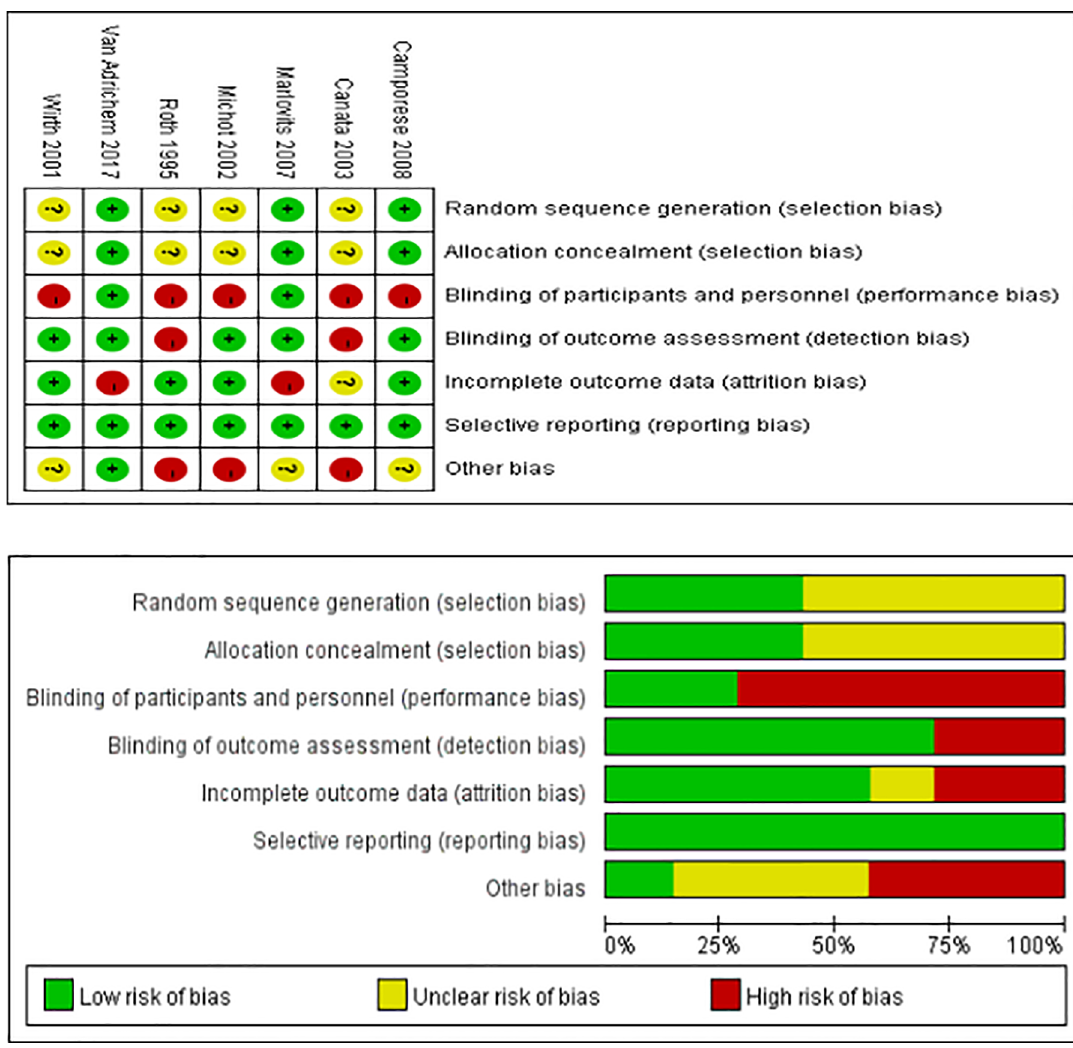
Fig 2. Risk of bias of the selected studies according to the Cochrane Collaboration tool. Panel A: Risk of bias graph: judgement regarding each risk of bias item presented as percentages across all studies. Panel B: Risk of bias summary: judgement regarding each risk of bias item for each study. A (+), indicates a low risk of bias; a (-), indicates a high risk of bias; and a (?), indicates an unclear risk of bias. All assessments were determined by consensus of the two independent authors. DVT in the LMWH group was lower (RR: 0.21; 95% CI: 0.07–0.63; P = 0.005, Fig 3). We used the fixed-effects model to combine symptomatic VTE data according to lower significant het- erogeneity ( I 2 value = 0%). Compared with the control group, after arthroscopic knee surgery, the incidence of symptomatic VTE in the LMWH group was not significantly different (RR: 0.90; 95% confidence interval [CI]: 0.39–2.08; P = 0.80, Fig 4). The fixed-effects model was used to combine symptomatic DVT data because heterogeneity was not evident ( I 2 value = 0%). The symptomatic DVT rate was 0.3% (6/2,166) in the LMWH group versus 0.4% (7/1,713) in the control group. In the overall data, the symptomatic DVT rate in the control group was not sig- nificantly different from that in the LMWH group (RR: 0.79; 95% CI: 0.28–2.23; P = 0.66, Fig 5). As a result of the lower heterogeneity of the data ( I 2 value = 0%), we used the fixed-effects model to combine the symptomatic PE data. The meta-analysis demonstrated that the symptomatic PE